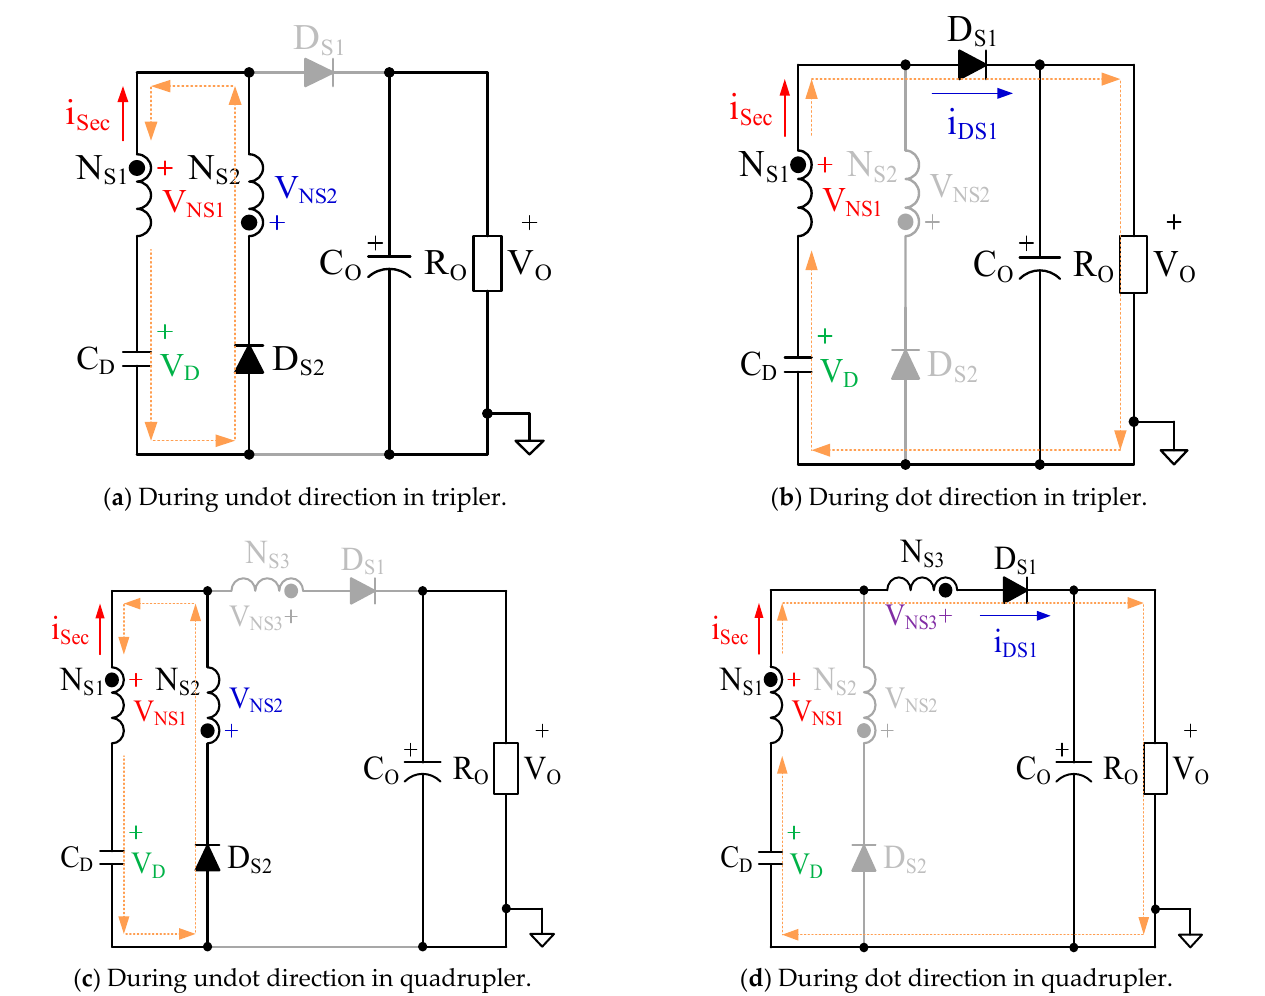
Figure 2. Operational modes of proposed rectifiers.